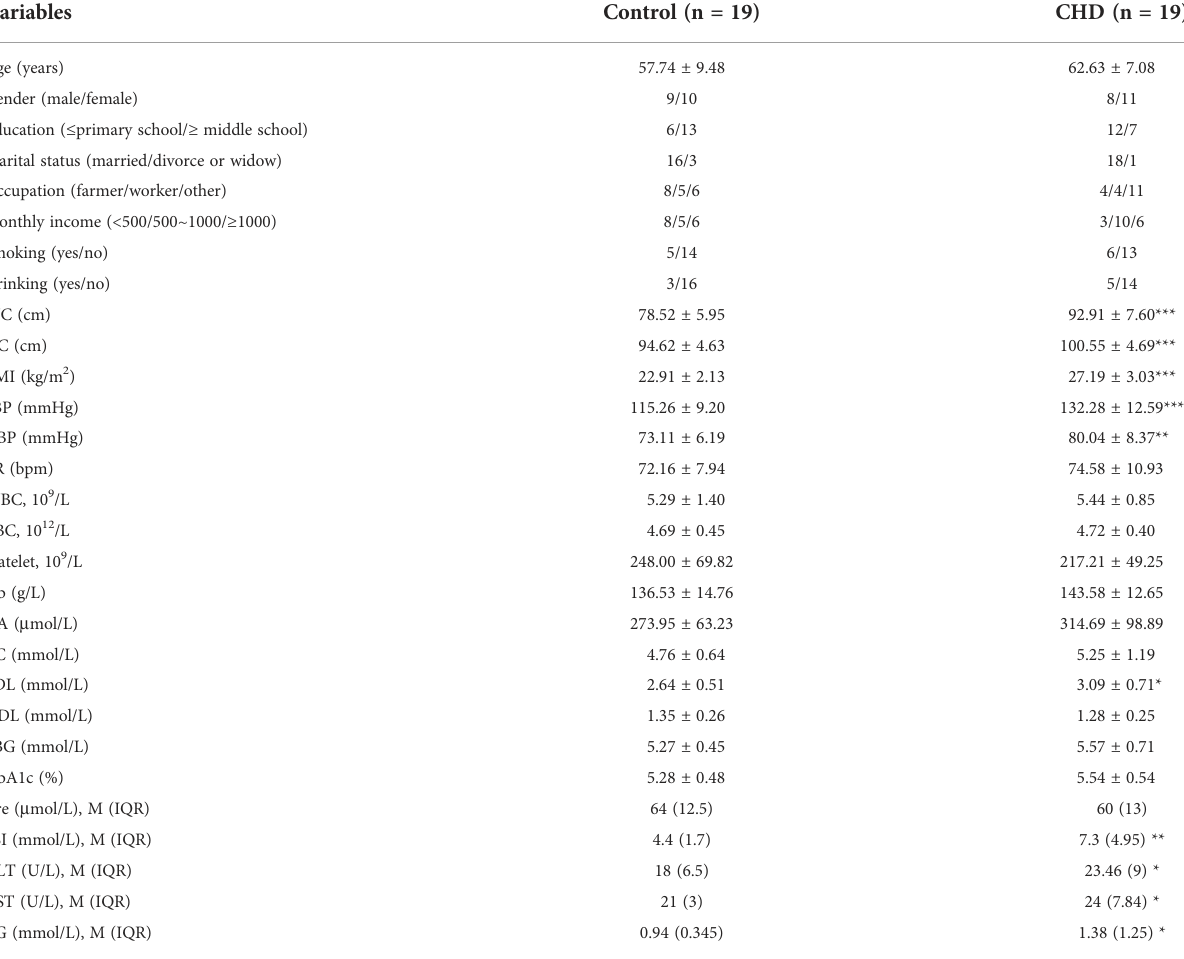
Values are presented as mean ± SD or median and interquartile range (IQR). All p-values are from the Welch ’ s t test or the Wilcoxon rank sum test, except for gender, education, marital status, occupation, monthly income, smoking, and drinking history ( c 2 tests or Fisher ’ s exact test). *p-value < 0.05; **p-value < 0.01; ***p-value < 0.001 vs. Control. WC,